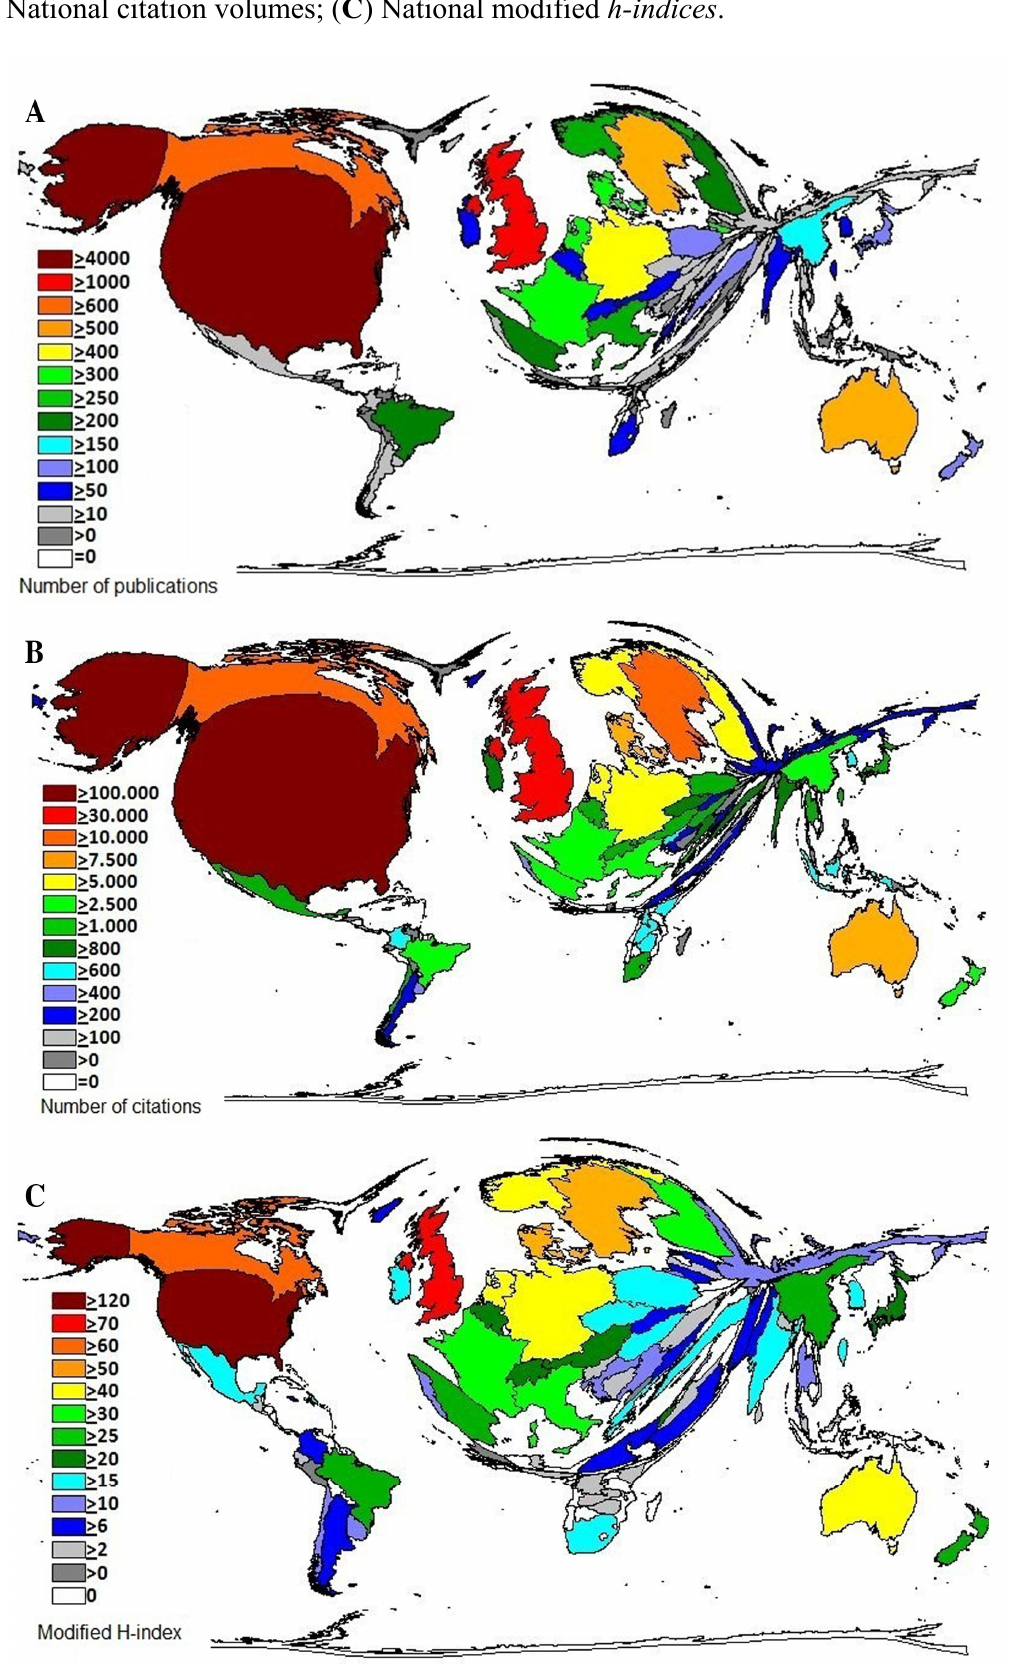
Figure 2. Density equilizing map projections. ( A ) National publication volumes; ( B ) National citation volumes; ( C ) National modified h-indices